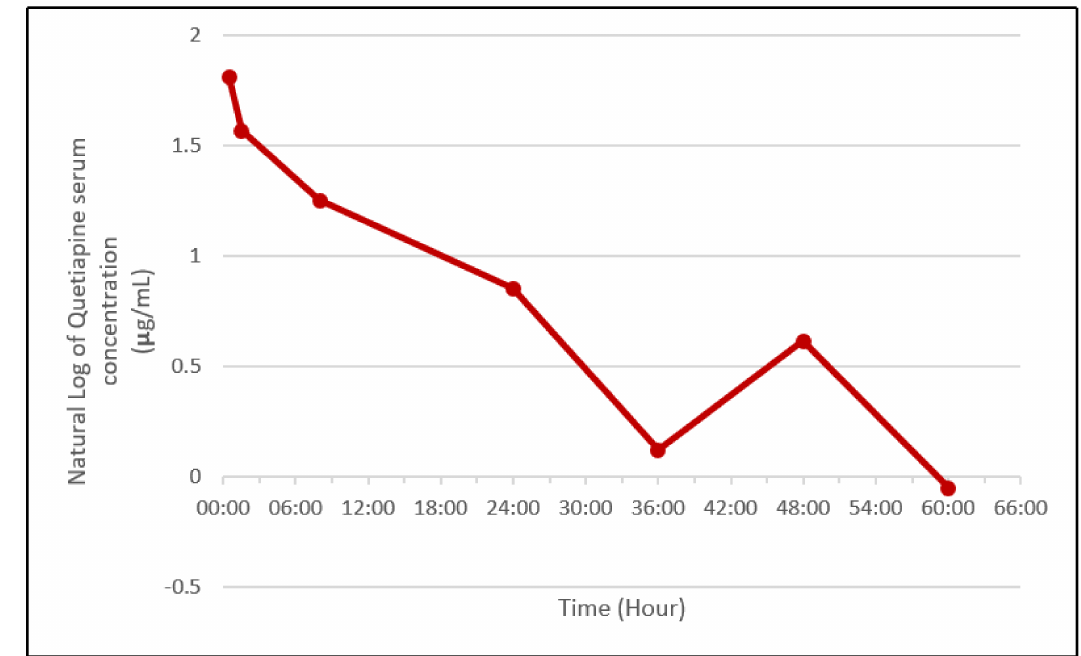
Figure 1. Serum time-related natural log of Quetiapine